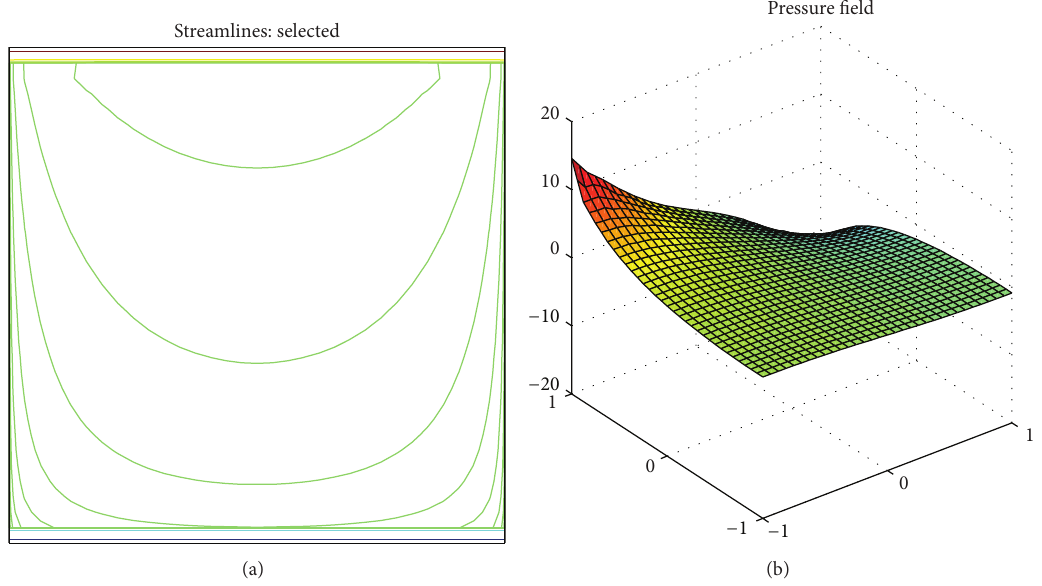
Figure 1: Velocity streamlines (a) and pressure plot (b) of the Stokes equation at level